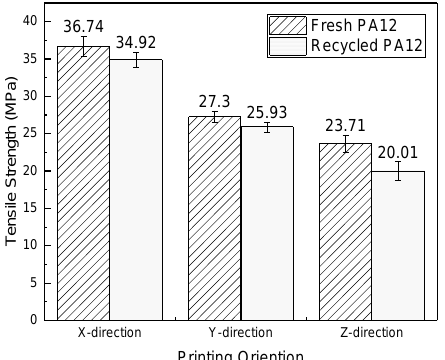
Figure 4. Tensile strength of test samples in different printing orientations.